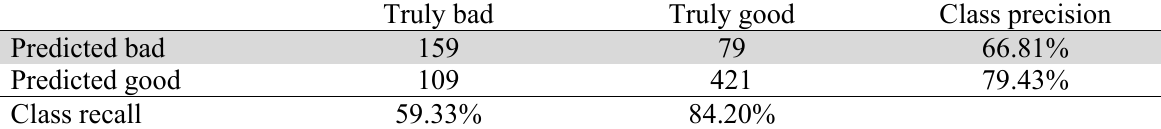
The results of the implementation of Naive Bayes Truly bad Truly good Class precision Predicted bad 159 79 66.81% Predicted good 109 421 Class recall 59.33%